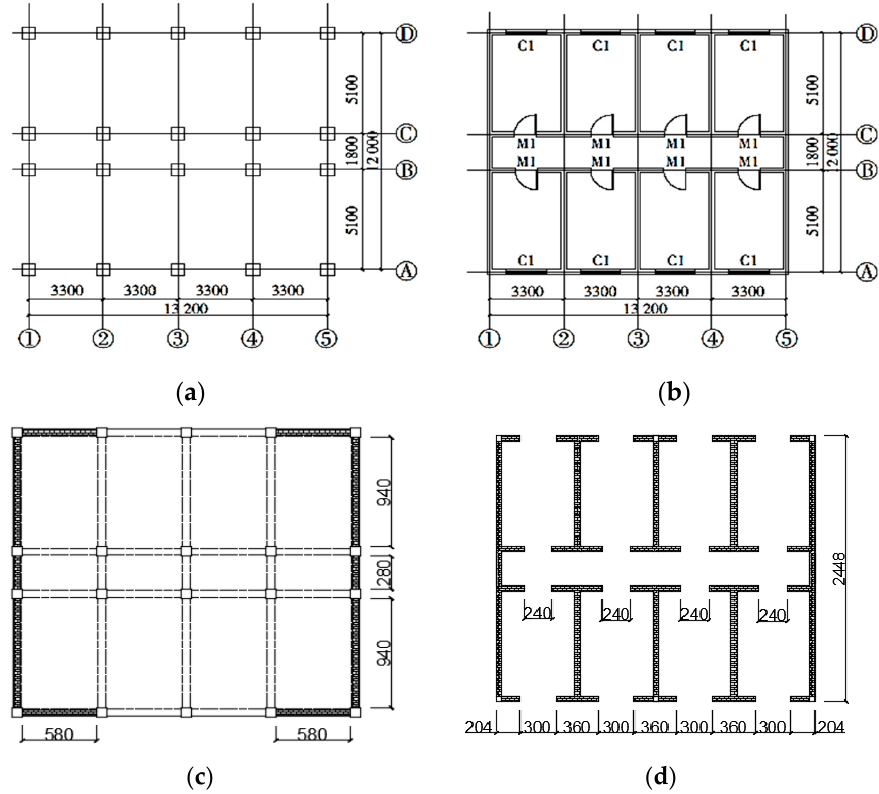
Figure 1. The floor plans of the bottom frame structure: ( a ) the bottom floor plan, ( b ) the standard story plan, ( c ) the anti-seismic wall plan in the bottom story, ( d ) the constructional columns in the upon stories. Table 1. The information of the tested bottom frame structure (mm). Table 2. The similarity of physical parameters.